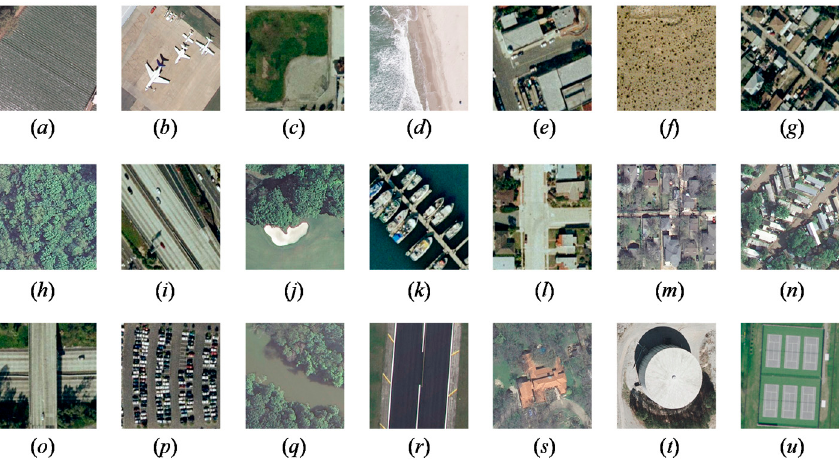
Figure 5. Representative images of the 21 land-use categories in the UC Merced dataset: ( a ) agriculture; ( b ) airplane; ( c ) baseball diamond; ( d ) beach; ( e ) buildings; ( f ) chaparral; ( g ) dense residential; ( h ) forest; ( i ) freeway; ( j ) golf course; ( k ) harbor; ( l ) intersection; ( m ) medium residential; ( n ) mobile home park; ( o ) overpass; ( p ) parking lot; ( q ) river; ( r ) runway; ( s ) sparse residential; ( t ) storage tanks; ( u ) tennis court.